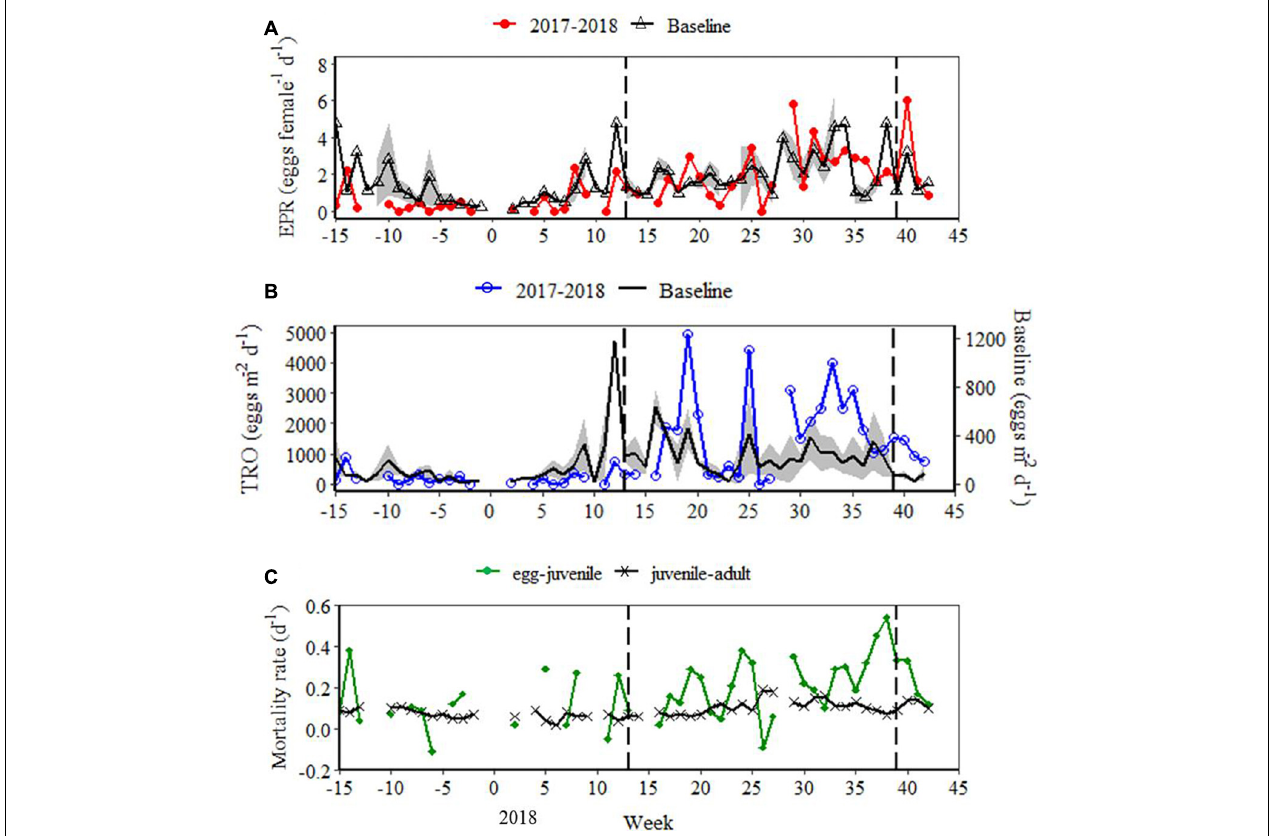
FIGURE 6 | (A) Oithona similis egg production rate (EPR) for the 2017–2018 study and weekly mean ( ± SE) O. similis EPR for the time series baseline (2003; 2011–2016); (B) O. similis total reproductive output (TRO) for the 2017–2018 study and weekly mean ( ± SE) O. similis TRO for the time series baseline (2011–2016), note the use of different axes due to divergence in sampling efficiencies between methods; (C) mortality rates ( β ) of O. similis egg-juvenile and juvenile-adult stage pairs for the 2017–2018 study. In (A , B) , baseline standard error is represented by the grey band. Vertical dashed lines mark the onset and breakdown of stratification, indicated by the switch in surface NHF from negative to positive (week 13), and positive to negative (week 39) during the 2017–2018